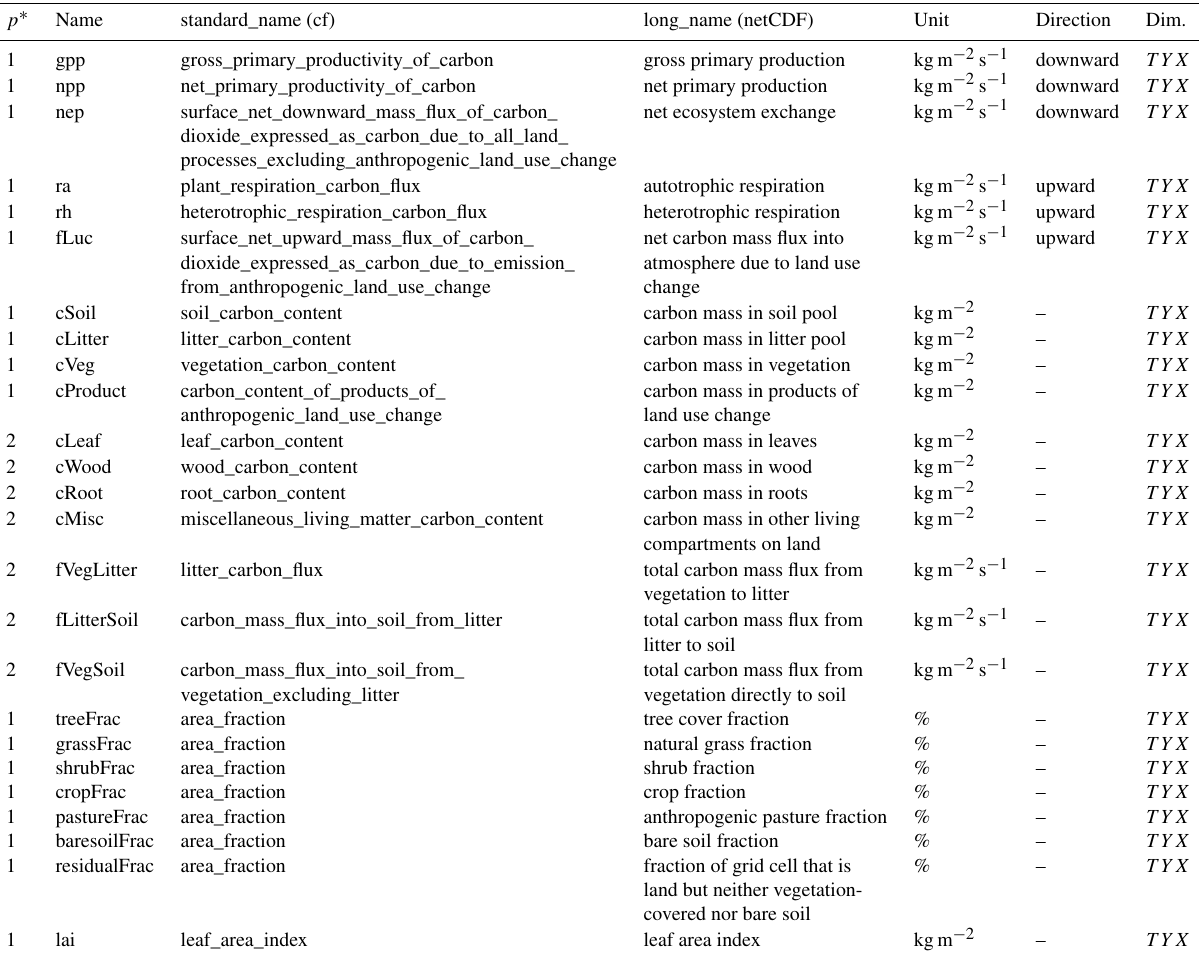
Table A3. Variable request table “LCmon”: monthly variables related to the carbon